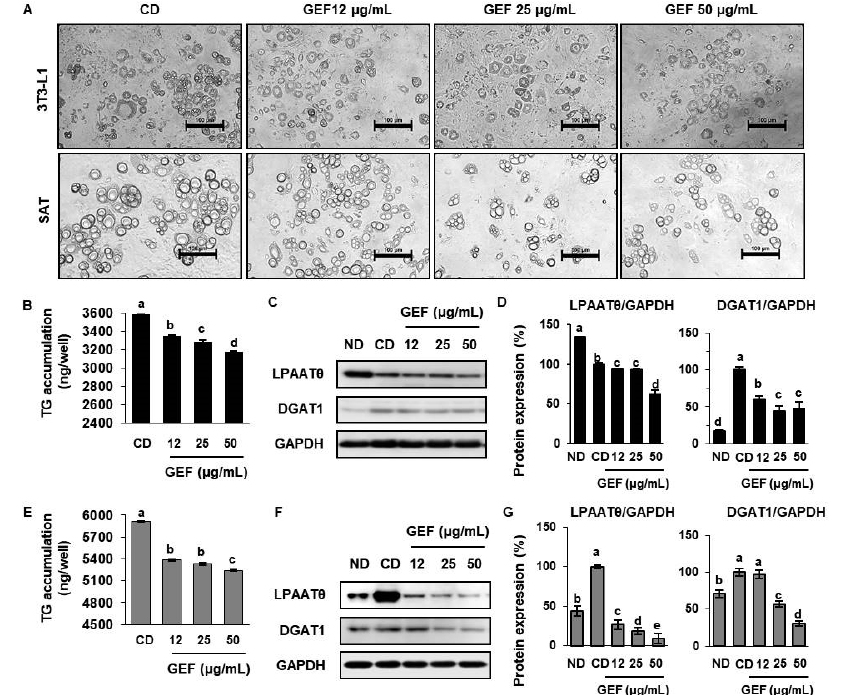
Figure 2. Effects of GEF on lipid droplet morphology and triglyceride synthesis in 3T3-L1s and SATs. ( A ) Cell morphology was evaluated by optical microscopy (400×). Adipocytes were differentiated for 16 days. Scale bar: 100 µm. ( B, E ) The intracellular triglyceride (TG) content of 3T3-L1s and SATs treated with GEF, measured using a TG ELISA kit. ( C–D ) Expression of lipogenic proteins (LPAATθ and DGAT1) in 3T3-L1s. ( F–G ) Expression of lipogenic proteins in SATs. Data are expressed as mean ± SD (n = 4). Treatments with different letters were significantly different, p < 0.05 (a > b > c > d).